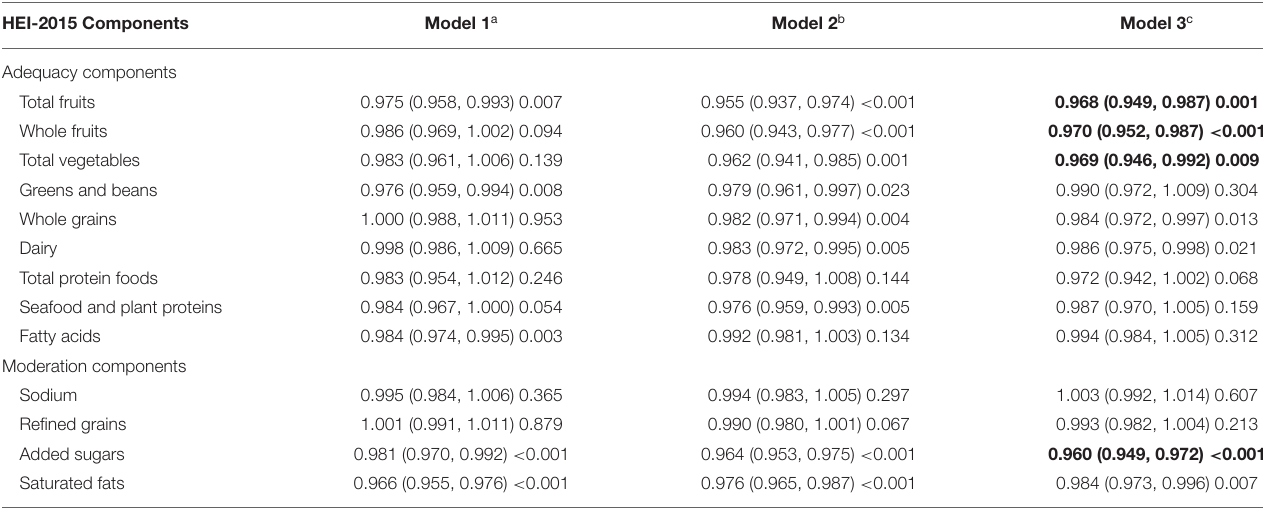
TABLE 3 | Association of HEI-2015 components with kidney stones.